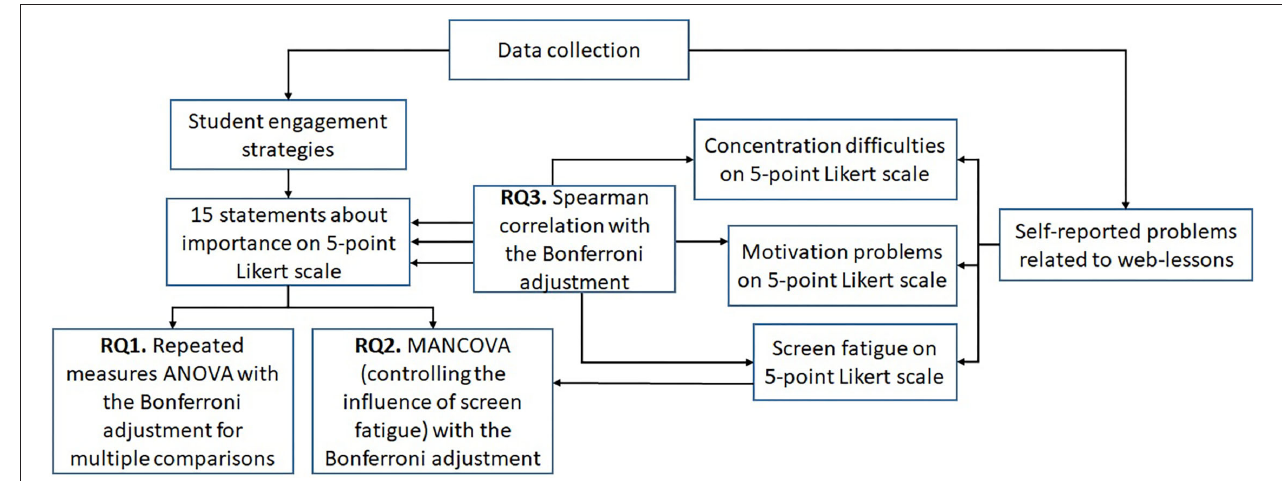
FIGURE 1 | Data collection and